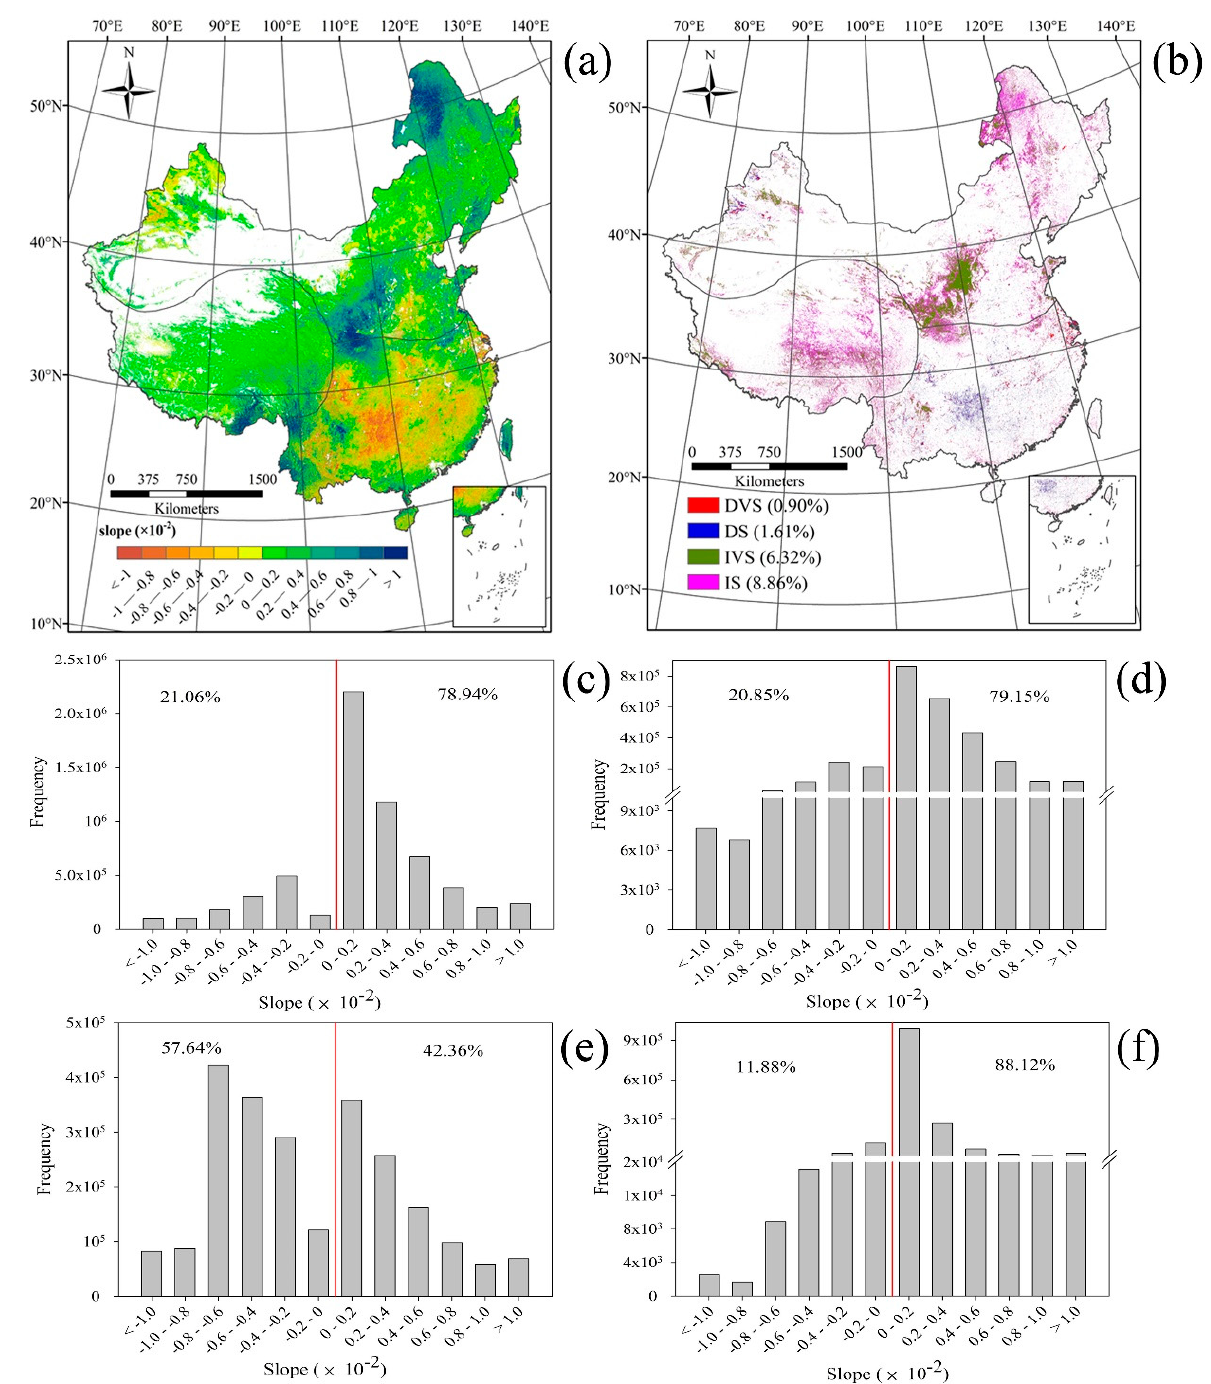
Figure 4. Trends in annual Net Primary Productivity (NPP) within China between 2001 and 2014 ( a ); and pixels with significant ( p < 0.05) and very significant ( p < 0.01) trends are shown in ( b ). The count distributions of NPP trends in China ( c ); Northern China ( d ); Southern China ( e ) and the Tibetan Plateau ( f ) are also shown. A positive trend indicated an increase in NPP and vice versa; DS and DVS represent decreased significantly and very significantly, respectively; and IS and IVS represent increased significantly and very significantly, respectively. The red lines in figures ( c ), ( d ), ( e ) and ( f ) represent boundary for negative slop and positive slop.